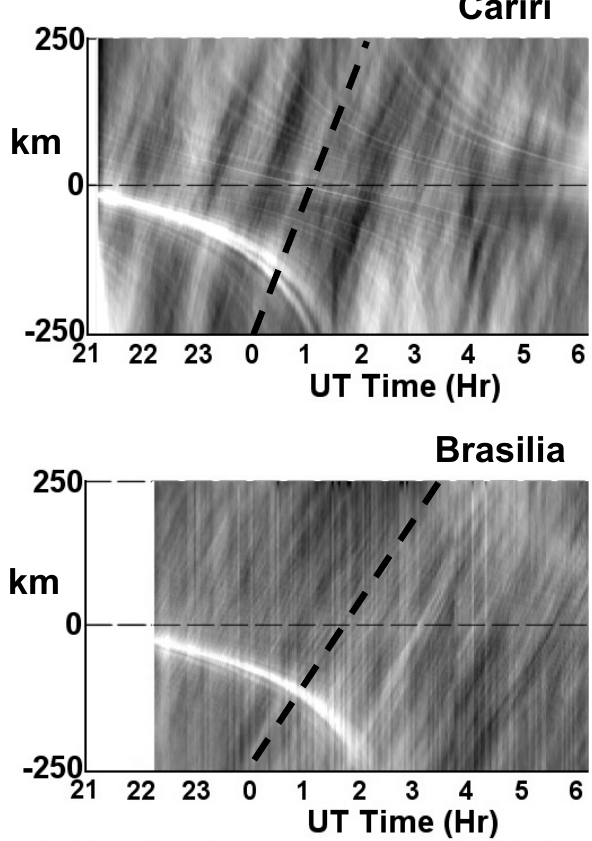
Fig. 1. Keograms prepared from east-west slices of OH airglow emissions obtained at Cariri (top) and Brasilia (bottom) on 1 Octo- ber 2005. Note that movement of structures at both sites is gener- ally eastward, but is faster and at ∼ 50 to 300-km zonal wavelengths at Cariri and slower and at ∼ 20 to 150-km zonal wavelengths at Brasilia. Typical eastward phase speeds for each site are shown with the heavy dashed lines in each